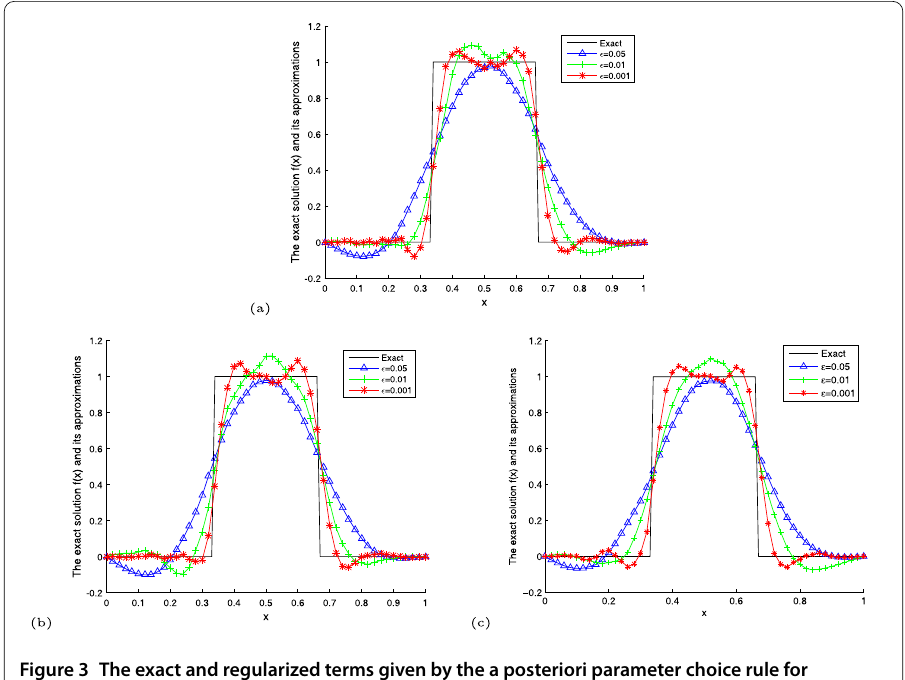
Figure 3 The exact and regularized terms given by the a posteriori parameter choice rule for Example 3: (a) α = 0.2, (b) α = 0.5, (c) α = 0.9.